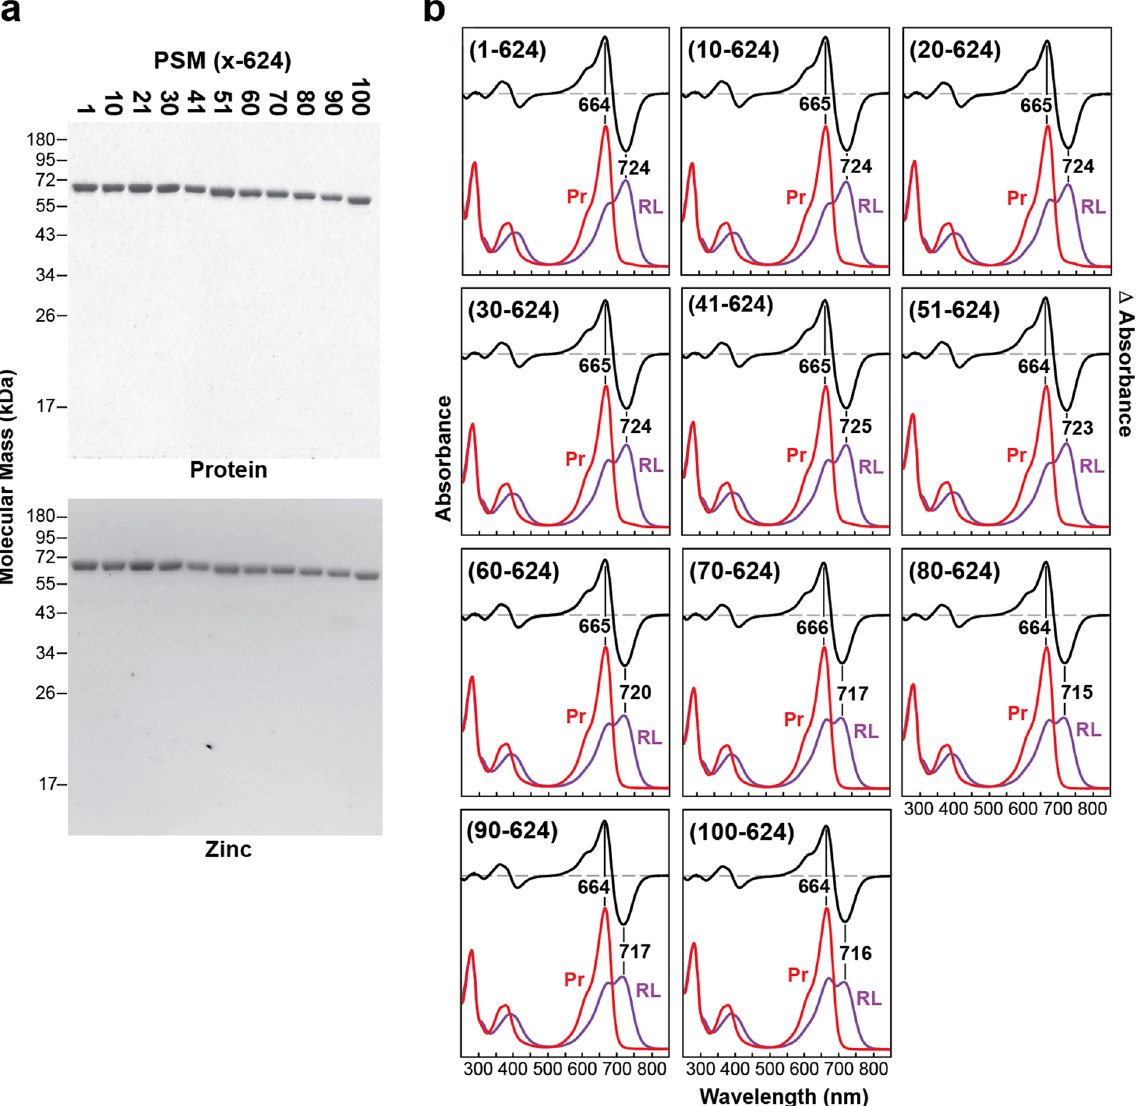
Figure 3. Spectroscopic properties of PSM mutants impacting the N-terminal extension (NTE) in PhyB. ( a ) Assembly of NTE truncations with P Φ B. Purified PSM fragments were subjected to SDS-PAGE and either stained for protein with Coomassie Blue or for the bound bilin by zinc-induced fluorescence. For full-length images of the SDS-PAGE gels see Supplementary Fig. S1. (b) UV-Vis absorption and difference spectra of dark- adapted samples (Pr, red) and samples irradiated to steady state with 230 μ mol ⋅ m − 2 ⋅ s − 1 of 630-nm red light (RL, purple). The difference spectra are shown at 70% total amplitude. The absorption and difference maxima/ minima are